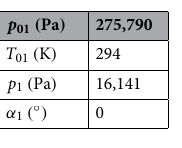
Table 4. Validation case main flow boundary